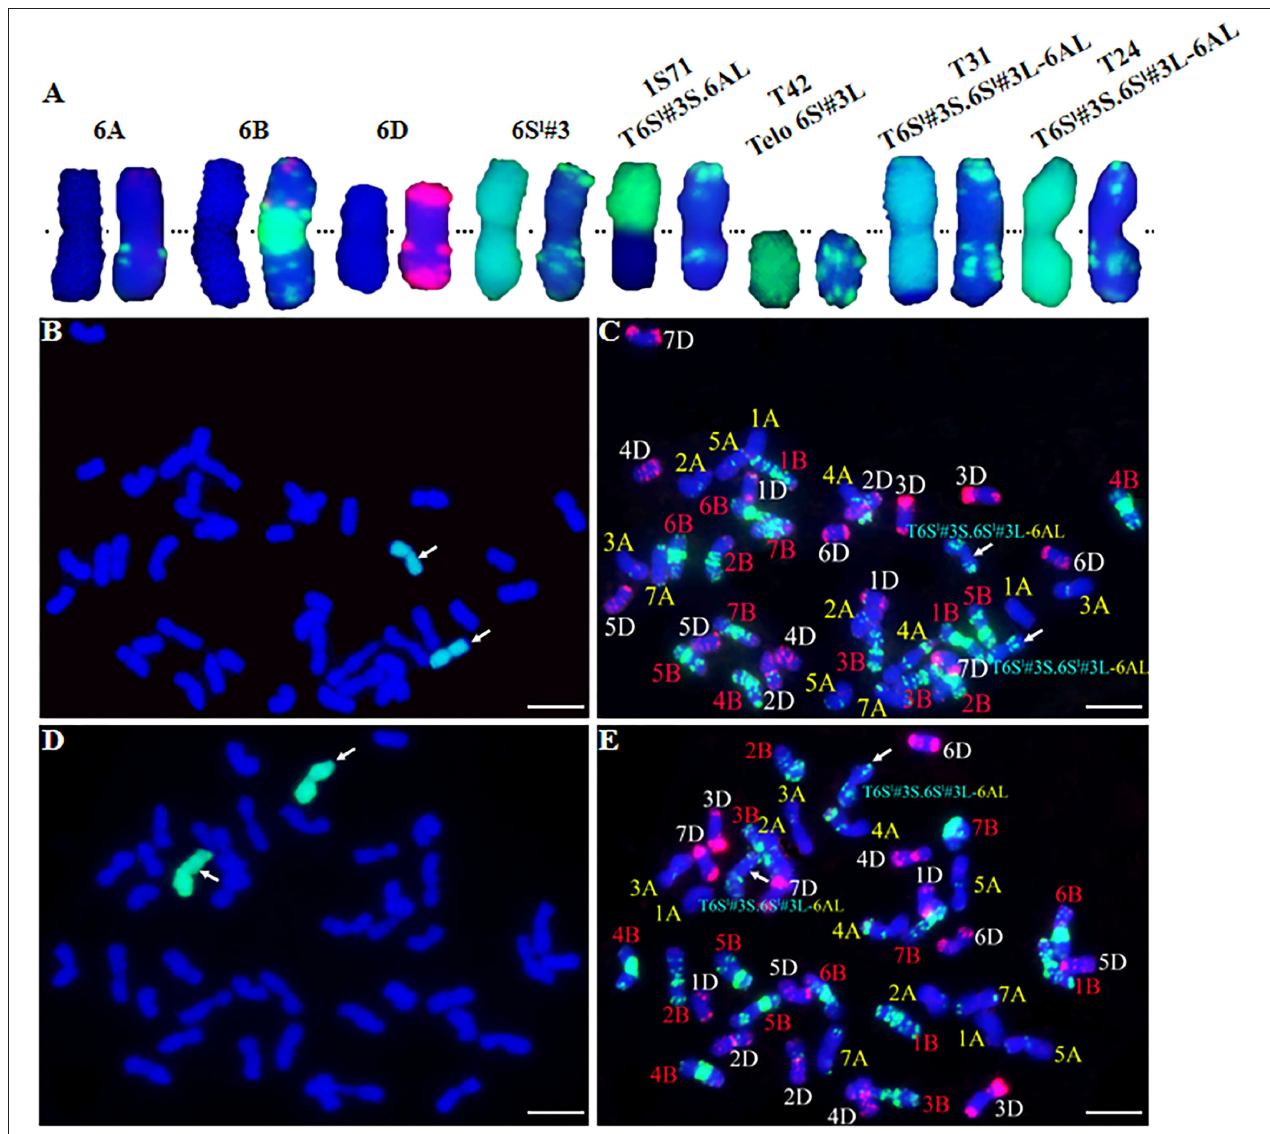
FIGURE 2 | GISH and FISH analysis of CS- Ae. longissima 6S l #3 introgression lines. (A) From left to right, chromosome pairs of 6A, 6B, 6D, 6S l #3, T6S l #3S.6AL (1S71), 6S l #3L telosome (T42), T6S l #3S.6S l #3L-6AL (T31), and T6S l #3S.6S l #3L-6AL (T24). The left and right chromosome of each pair is GISH and FISH, respectively. (B–E) GISH and FISH patterns of T31 (B,C) and T24 (D,E) . Arrows indicated the recombined chromosomes involving 6S l #3. Ae. longissima chromatin is visualized by green florescence and wheat chromosomes are counterstained with DAPI and fluoresced blue in GISH. In FISH, TAMRA-modified